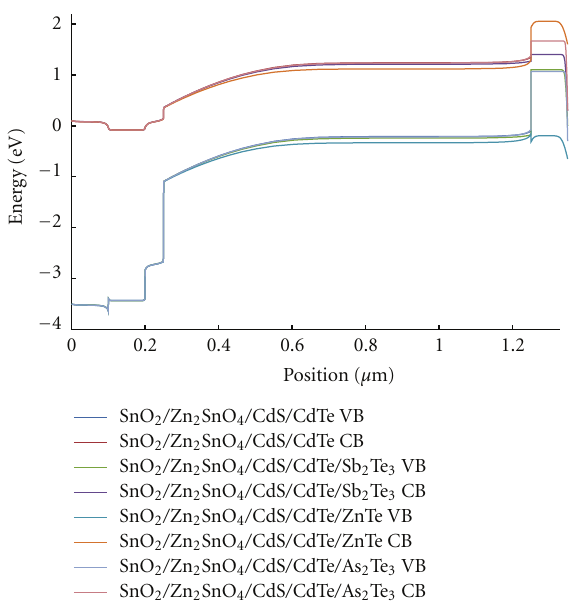
Figure 7: Band diagram of the proposed